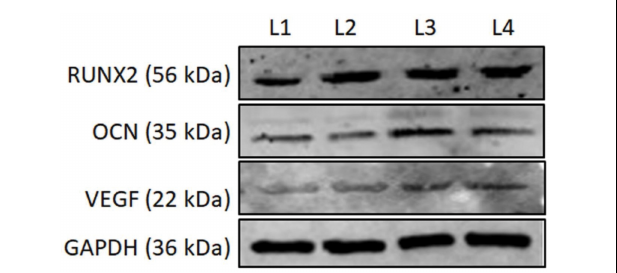
FIGURE 9 | The Western blot images of RUNX2, OCN, and VEGF on the 14th day posttreatment with various composites. L1, Control; L2, BM-HA treated; L3, BM-HA/PPA treated; L4, BM-HA/PPA/UMB treated. GAPDH, Loading